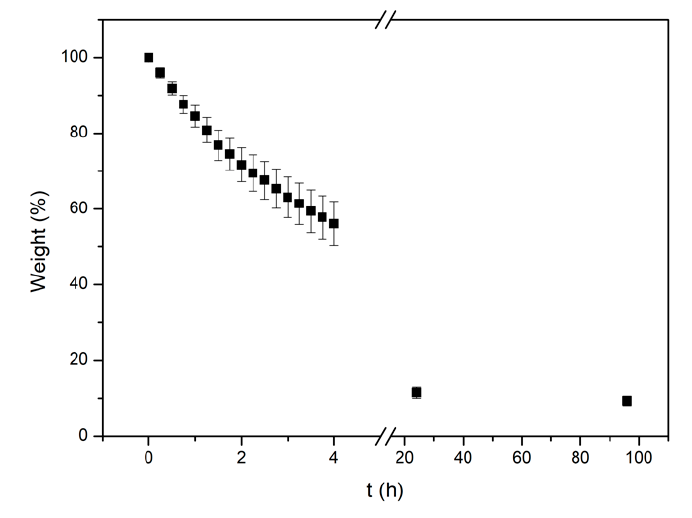
Figure 3. The films relative water weight with the time of the measurement.